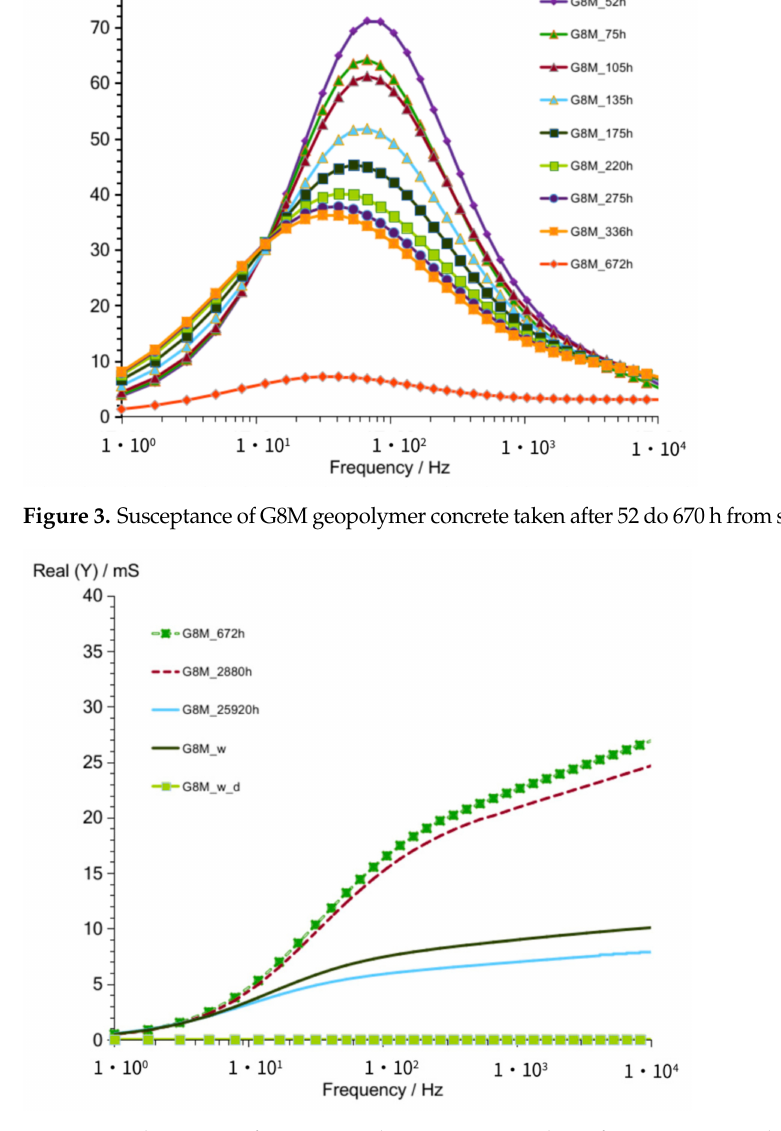
Figure 4. Admittance of G8M geopolymer concrete taken after 672 to 25,900 h from starting polymer- ization after removing conductive ions (G8M_w) and drying concrete